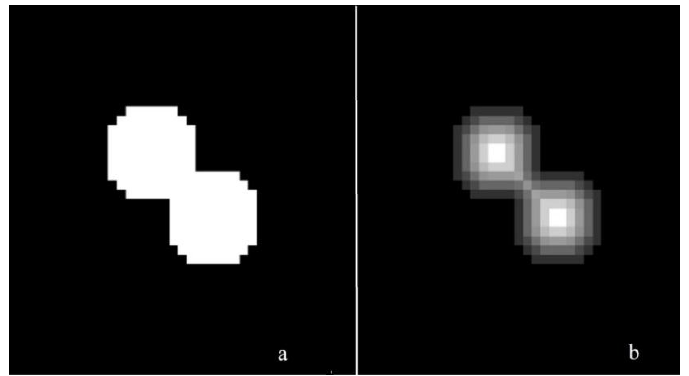
Figure 2. ( a ) Original image ( b ) Distance transformed